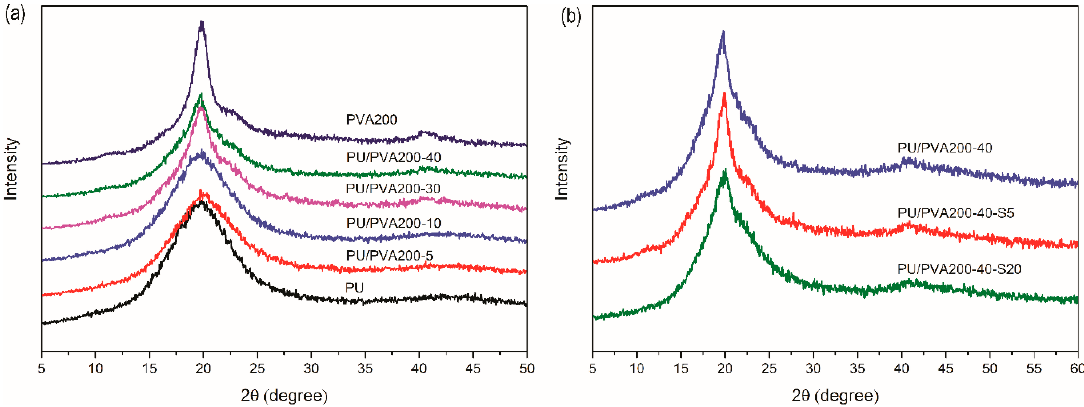
Figure 2. FTIR spectra of silica particles, PU / PVA200, and PU / PVA200 / silica MMMs.